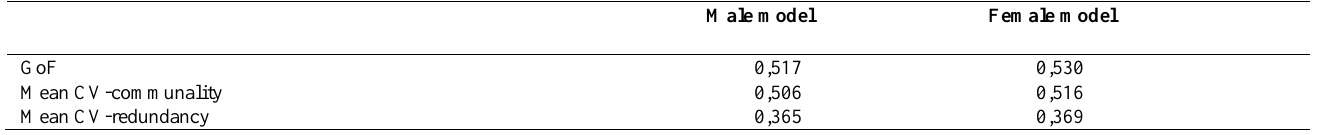
Table 8: GoF and blindfolding